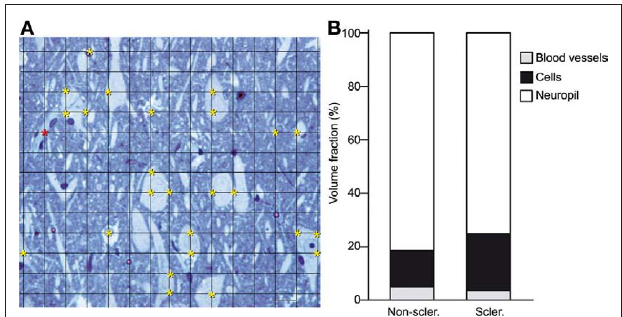
FigurE 3 | (A) Photomicrograph of a semithin section (2 μm) stained with 1% toluidine blue, showing the pyramidal cell layer of the subiculum from a non-sclerotic hippocampus to illustrate the Cavalieri method used to estimate the V . A grid of small intersections overlying the tissue is displayed. Each grid v point has an associated area of 20 × 20 = 400 μm 2 . In this example, the total area of the image is 78,000 μm 2 . Yellow asterisks indicate the intersections in the grid that lies within cell bodies ( n = 25, 25 × 400 = 10,000 μm 2 ). Red asterisks indicate the intersections in the grid that lies within blood vessels ( n = 1, 1 × 400 = 400 μm 2 ). The V of cells, blood vessels, and neuropil was v estimated with the following formulae: V = 12.8%, V = 0.51%, v cells v blood vessels V